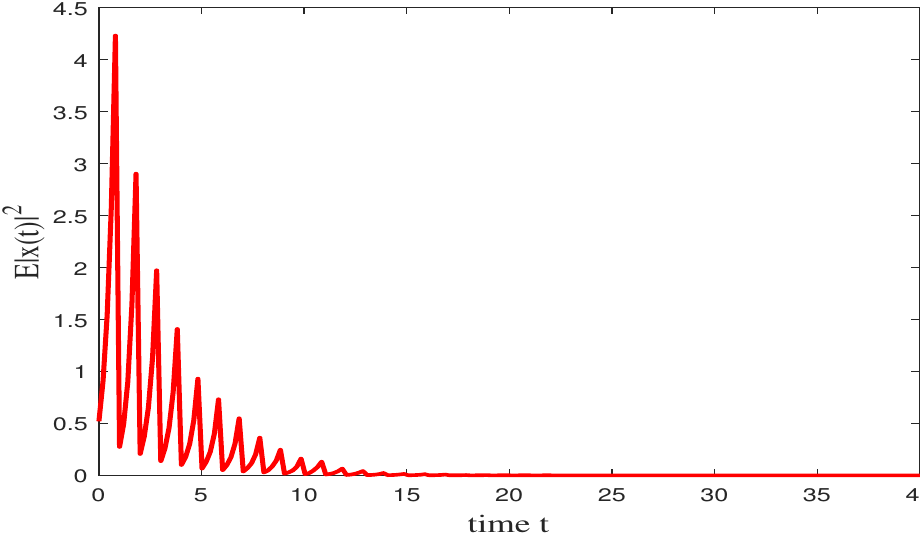
Figure 1. State trajectories of (44) with impulsive